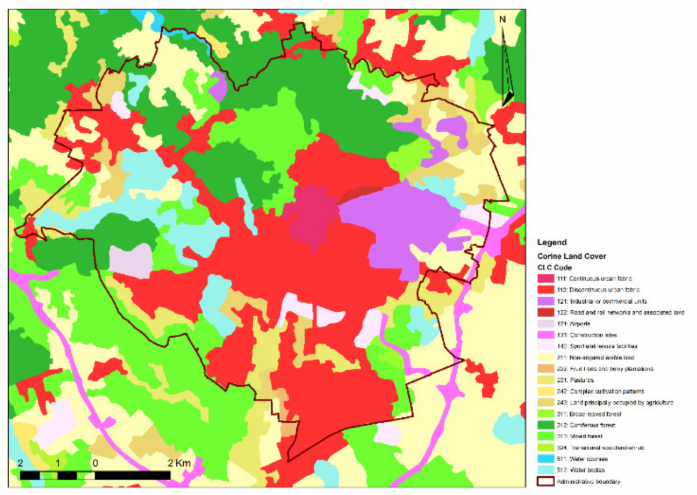
Figure 8. Land cover model in the area under investigation based on the CLC data. Source: [48].